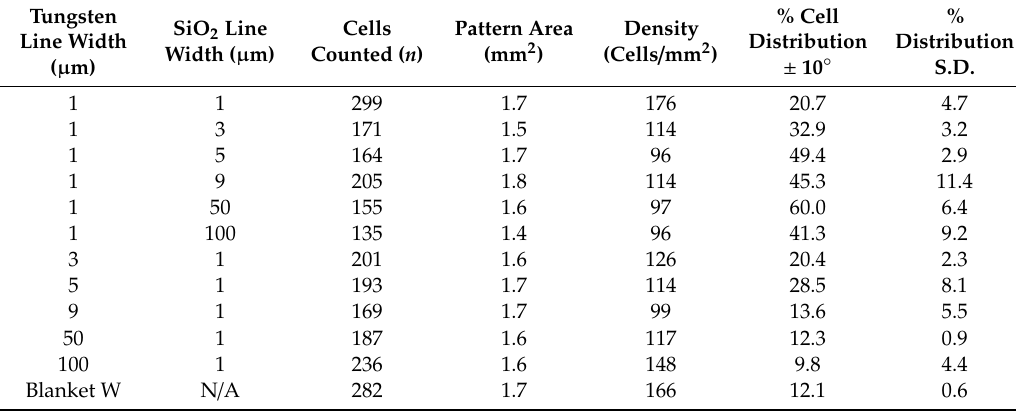
Table 1. Results of adherent cell alignment behaviors on asymmetric patterned comb structures. Tungsten and silicon oxide line widths varied independently in the range of 1 to 100 µ